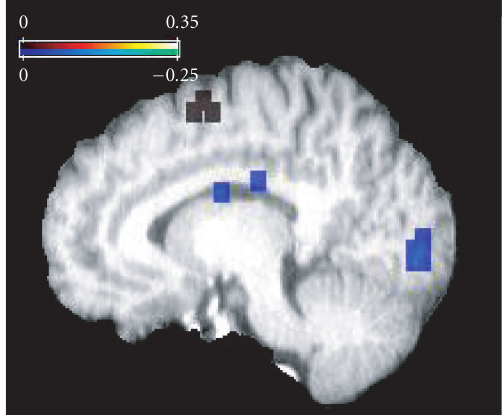
Figure 6: B-intercept map for Pei ff er plot at x = 10mm. Cool- colored voxels show negative b-intercept values where older adults have lower activity than younger adults. Note the large clus- ter within the occipital area. Warm-colored voxels indicate pos- itive b-intercepts where older adults show greater activity than younger adults. Interestingly, several contiguous voxels were iden- tified within right motor cortex and indicated increased bilateral activity in older relative to younger adults across the 4 detection